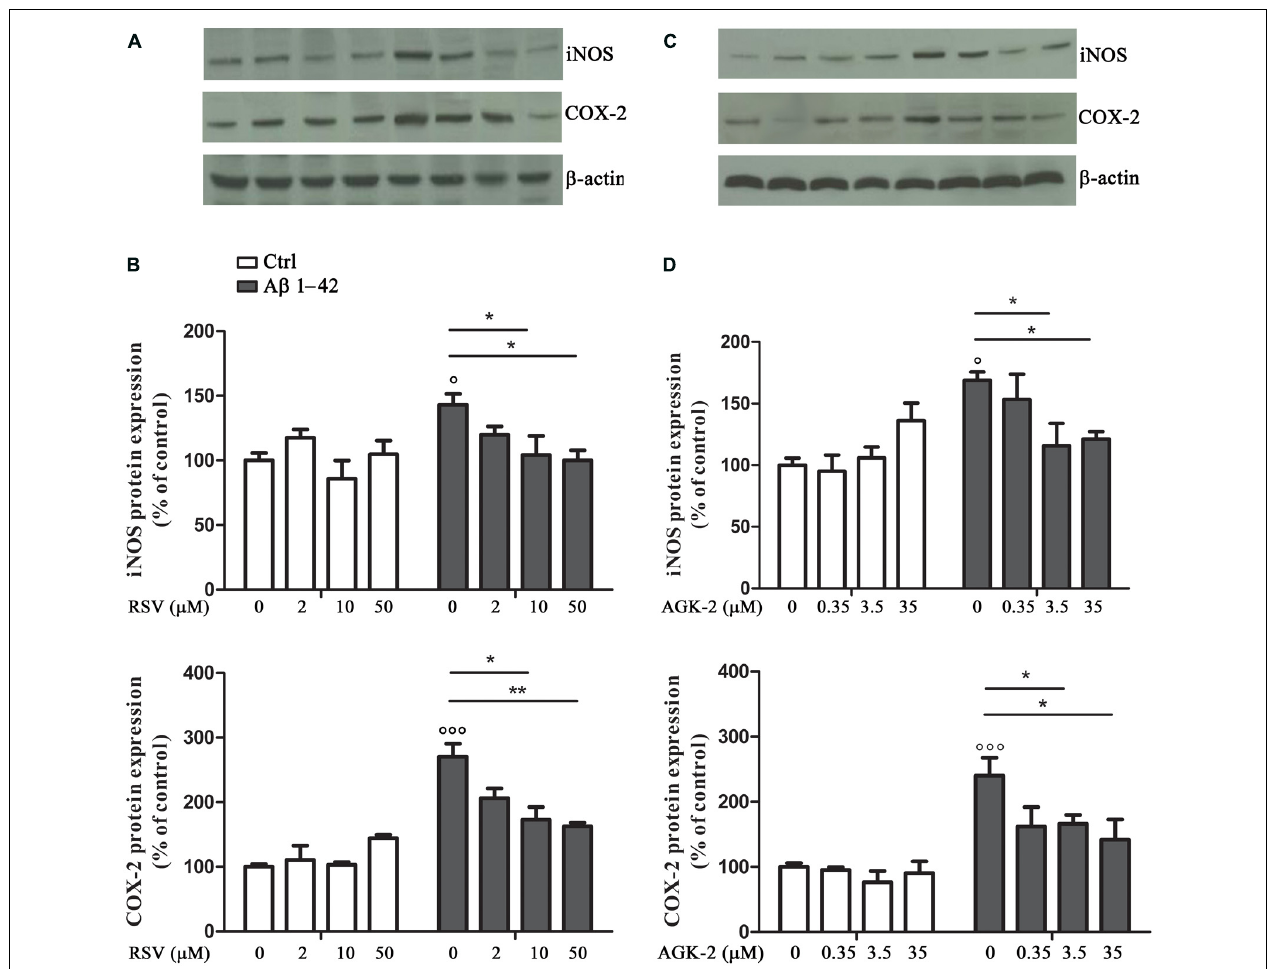
normalized to β -actin loading controls ( B,D for RSV and AGK-2, respectively). Results are the mean ± SEM of four experiments in triplicate. Statistical analysis was performed by one-way ANOVA followed by Bonferroni multiple comparison test. p < 0.001 and p < 0.05 A β -challenged versus